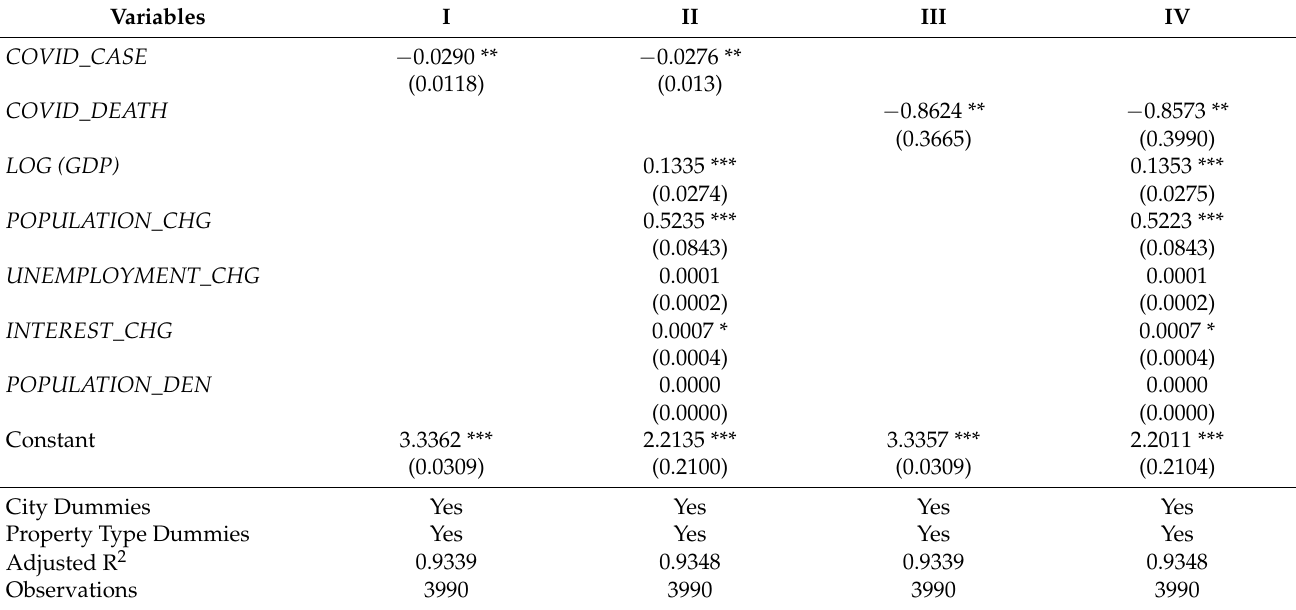
Table 4. The Impact of the COVID-19 Pandemic on Rent Dynamics by Cases and Deaths. This table presents the OLS regression estimation results of testing the impact of the COVID-19 pandemic on commercial real estate rent. The dependent variable is LOG (RENT) , the natural logarithm of rent for the specific city and property type. The independent variables of interest are COVID_CASE, and COVID_DEATH , which represent the total cumulative COVID-19 confirmed cases and deaths by country/jurisdiction, respectively. All variables are described in Appendix A. The standard errors are reported in parentheses. ***, **, and * denote significance of the t-statistics at the <1%, 5% and 10% levels, respectively.